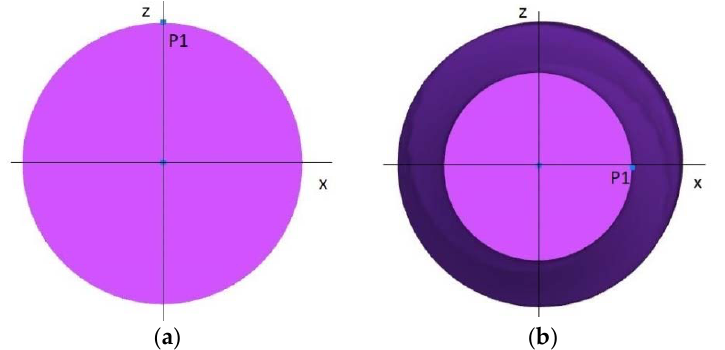
Figure 11. Location of point P1: ( a ) initial position on the surface of the billet; ( b ) final position on the surface of the forging.